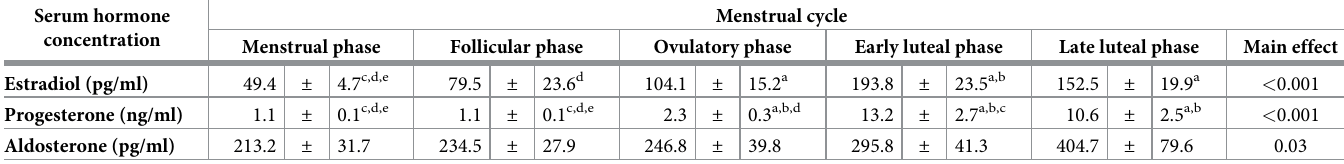
Table 1. Hormone levels in blood over the 5